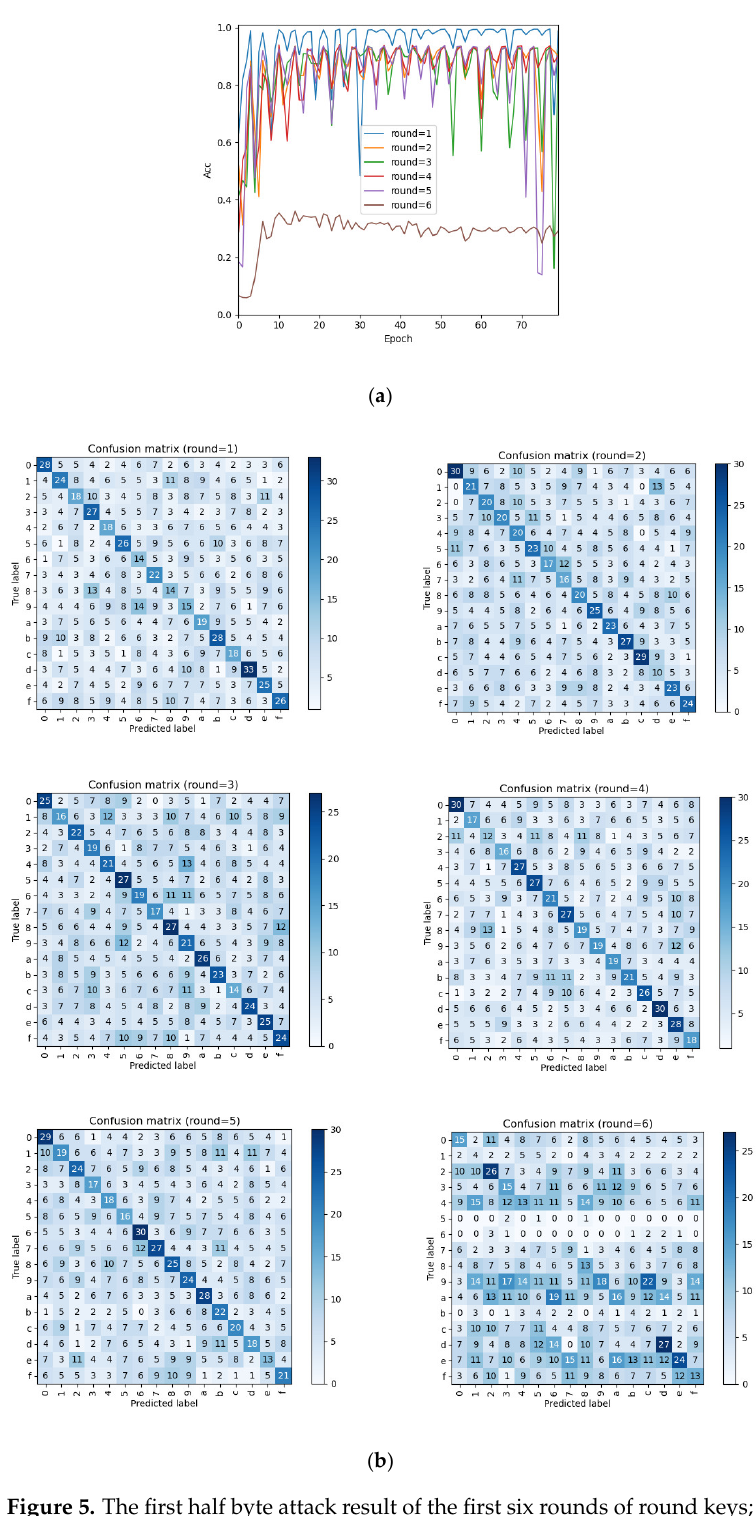
Figure 5. The first half byte attack result of the first six rounds of round keys; they should be listed as: ( a ) shows the learning curves, and ( b ) shows the confusion